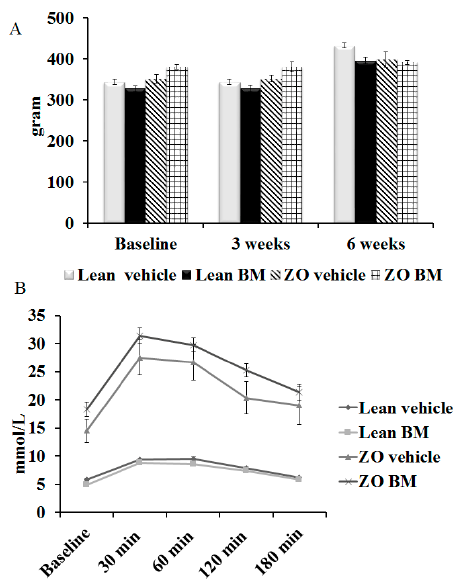
Figure 1. ( A ) Bitter melon (BM) extract effect on body weight. Six-week time course monitoring of body mass was conducted on Lean or Zucker Obese (ZO) rats ( n = 10 animals in each group), fed daily by gavage, with mucin–water vehicle, or BM extract of 400 mg/kg body weight, at outset (Baseline) and the three-week and six-week time points. Results are provided as average body mass, in grams, ± SEM; ( B ) Effect of bitter melon extract on serum glucose metabolism. Lean or Zucker Obese (ZO) rats ( n = 10 animals per group), fed daily by gavage, for six weeks with mucin–water vehicle, or BM extract of 400 mg/kg body weight, are evaluated for fasting serum glucose content immediately prior to oral administration of 3 g of glucose per kg of body weight (Baseline). Results are provided as